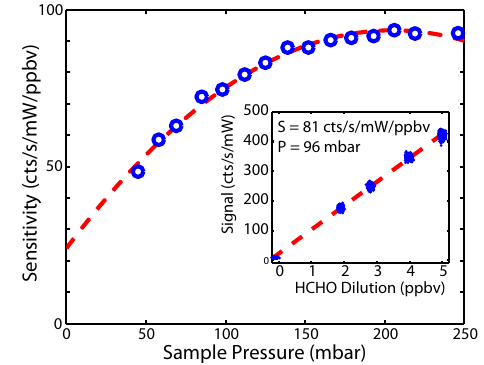
Figure 7. This plot shows the sensitivity of the instrument to HCHO versus pressure. The inset shows an example of a calibration using an HCHO standard addition to a flow of air. Several calibrations at one pressure are used to determine the pressure dependence.